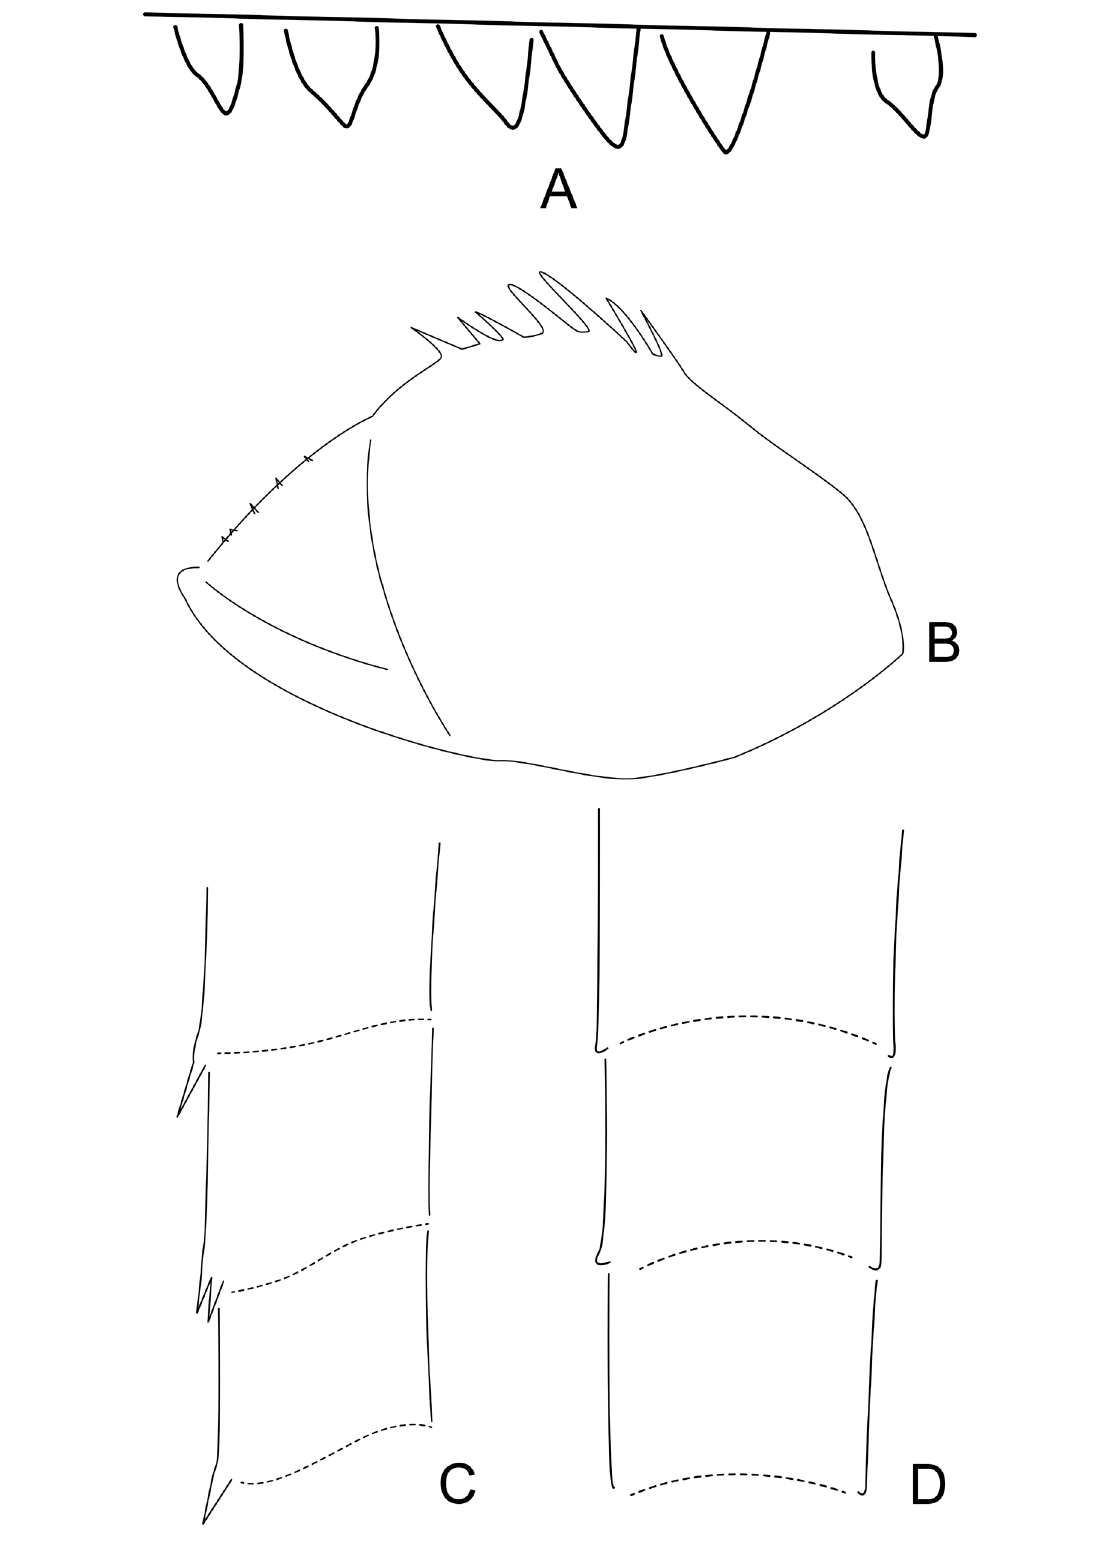
Fig. 10. Rivudiva oxum sp. nov., holotype (INPA). A . Margin of tergum IV. B . Paraproct. C . Cercus. D . Paracercus. Not to